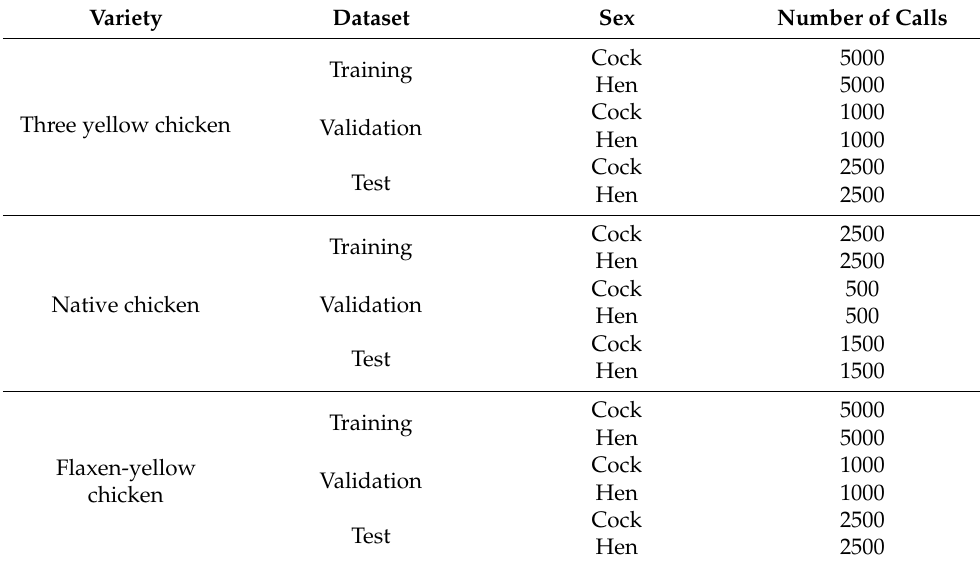
Table 2. The number of calls in each